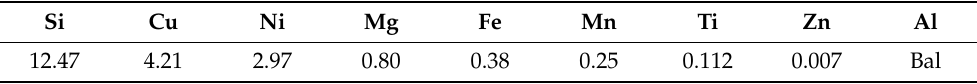
Table 1. Chemical composition of the Al–12Si alloy